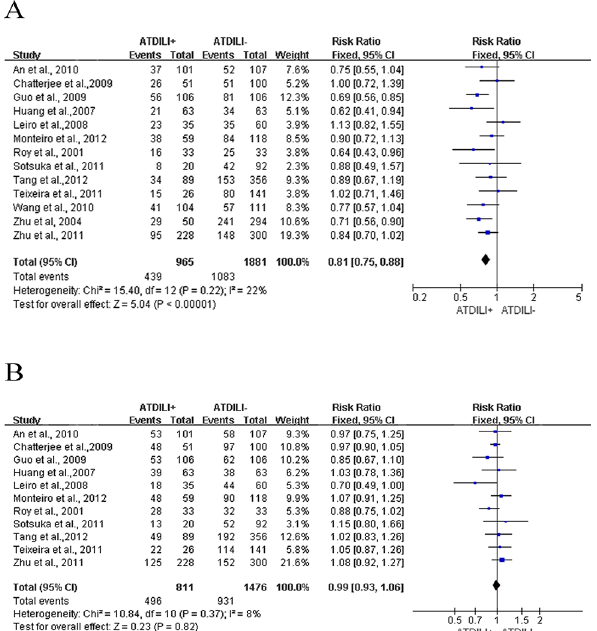
Fig 2. Forest plots for meta-analysis of GSTM1/T1 polymorphisms and ATDILI. A. the summary of RRs with 95% CIs for GSTM1 present genotype; B. the summary of RRs with 95% CIs for GSTT1 present